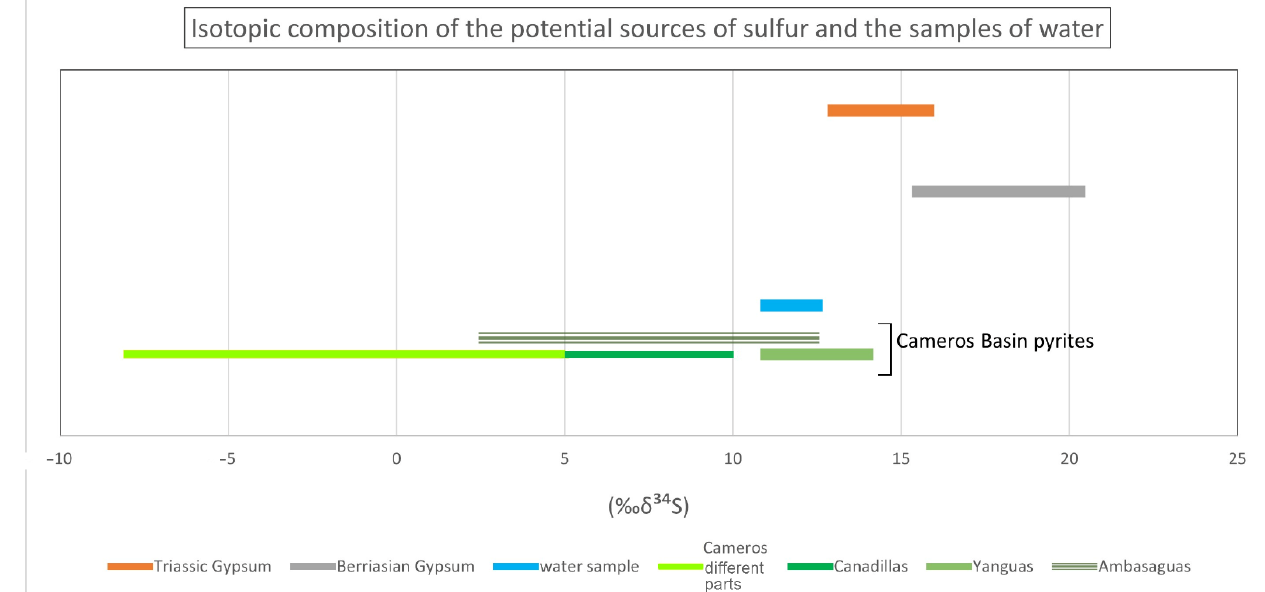
Figure 8. Isotopic composition of potential sources of sulphur and samples of water. Values of the δ 34 S isotope in ‰ are graphically represented in samples of pyrites, gypsum (Berriasian and Triassic, in grey and orange, respectively), and water (in blue). Relationships in light green correspond to pyrite samples from the Cameros Basin; in lime green, the values of different zones are reflected; pyrite samples studied from the localities of Canadillas and Yanguas [32] (in alpine green and pastel green respectively) reflect higher values. Isotopic ratios in ‰ δ 34 S obtained from the Berriasian and Triassic gypsum are higher than those of the analysed water samples. The ‰ δ 34 S values of the analysed water samples (11–12.5) would be in the range measured in the pyrites of the Cameros Basin, specifically with those located near the town of Ambasaguas, close to the study area. For this reason, this area is considered as a possible source of sulphur for the analysed waters.